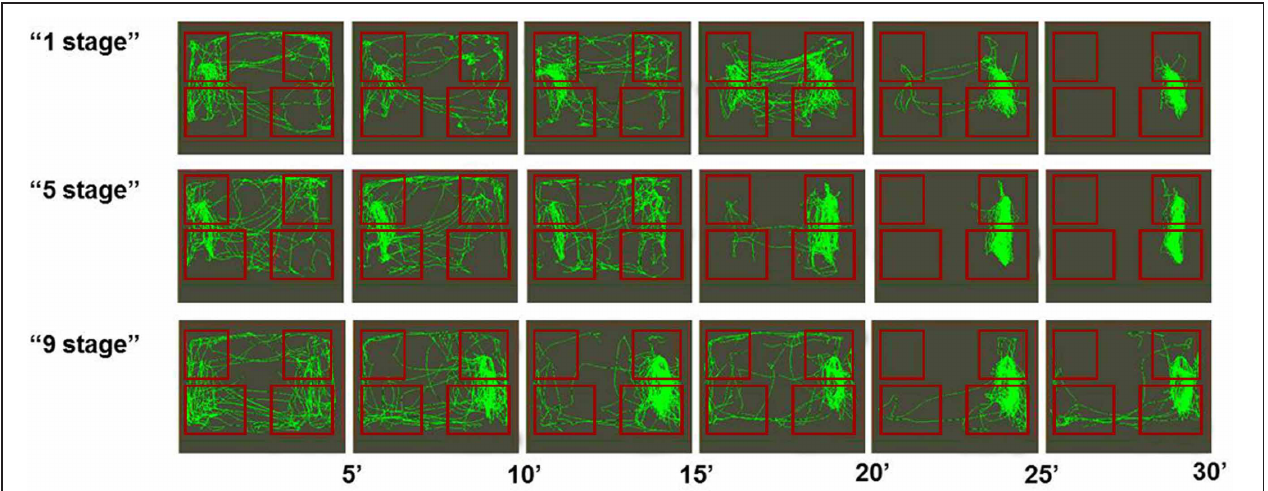
FIGURE 3 | Movement paths of representative rats (from all three groups) that successfully learned Task 2. Rectangles represent feeder zones (at the top) and bar zones (at the bottom). Rewarded locations are on